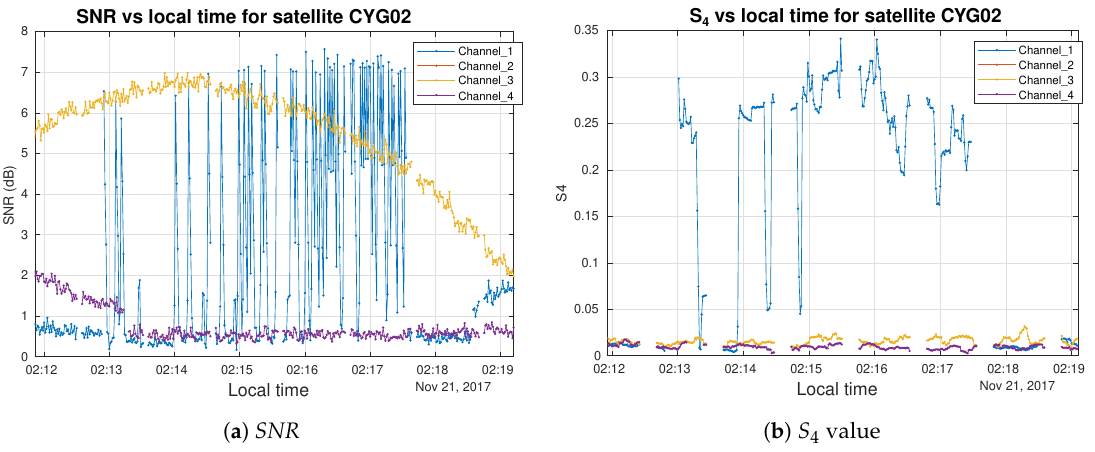
Figure 7. S 4 peak in middle Atlantic.